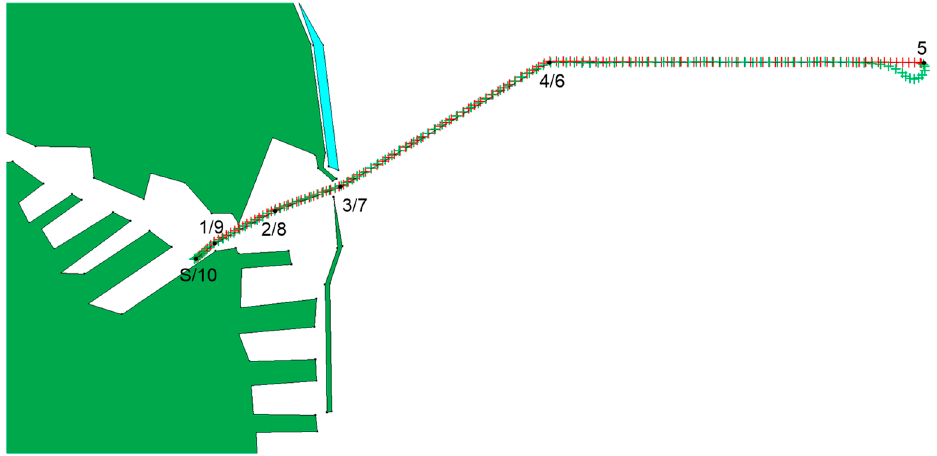
Figure 19. Route traveled by the simulated tugboat.